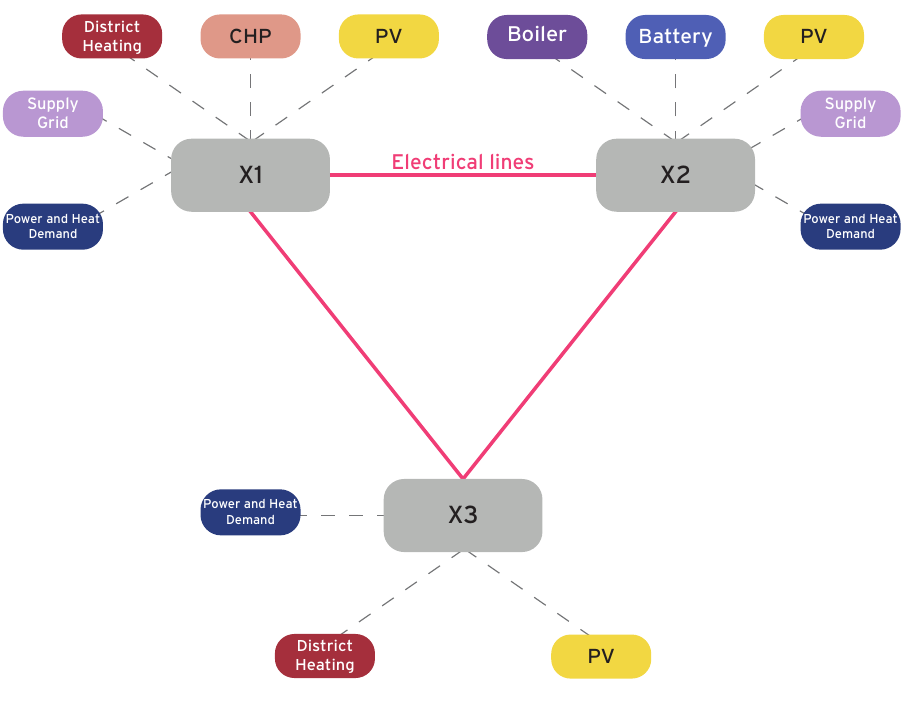
Figure 4. Case study example.